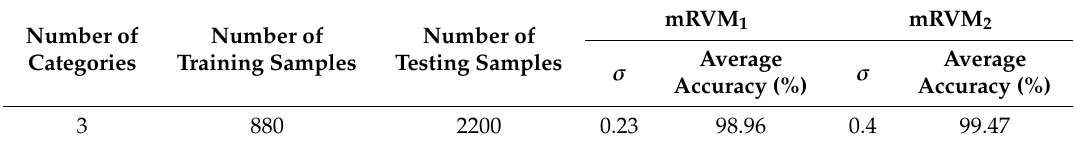
Table 5. Fault identification accuracy irrespective of the load and the fault diameter.